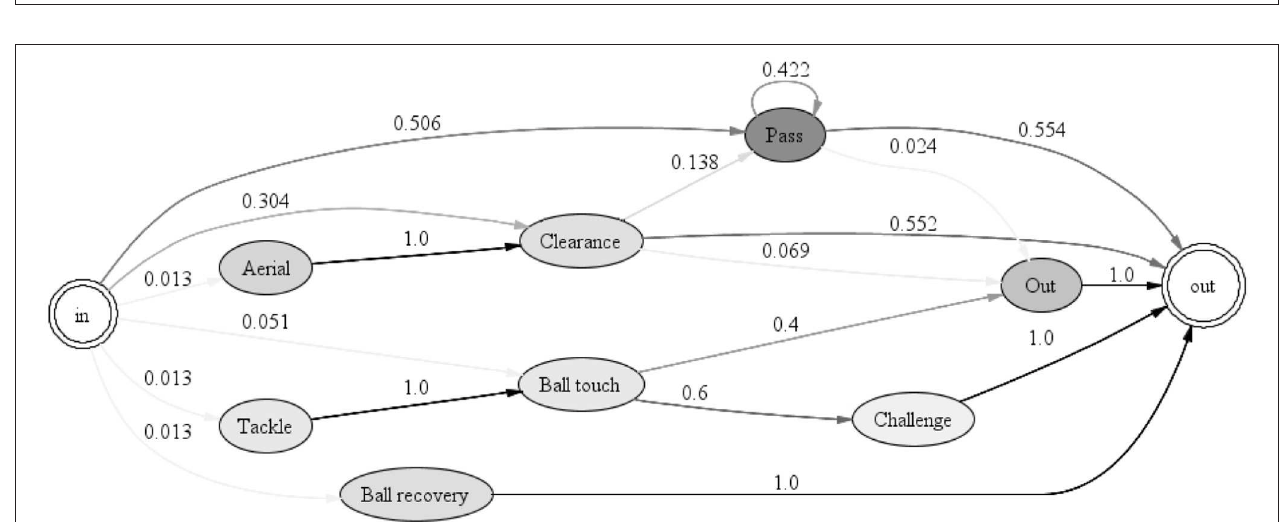
FIGURE 8 | Markov chain for Iceland’s team: cluster 3 with 34 instances.